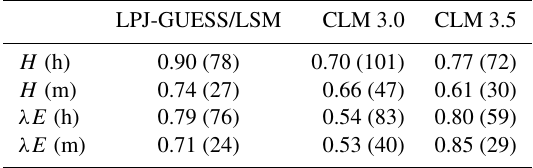
Table 9. Average correlation and RMSE between observed and sim- ulated sensible and latent heat fluxes for LPJ-GUESS/LSM, CLM 3.0, and CLM 3.5. RMSE values (between brackets) are given in Wm − 2 . Hourly and monthly values are labelled (h) and (m), respec- tively. CLM values correspond to averages over temperate, tropi- cal, and grassland sites as reported in Stöckli et al. (2008). LPJ- GUESS/LSM values correspond to the CLM/Med simulation.